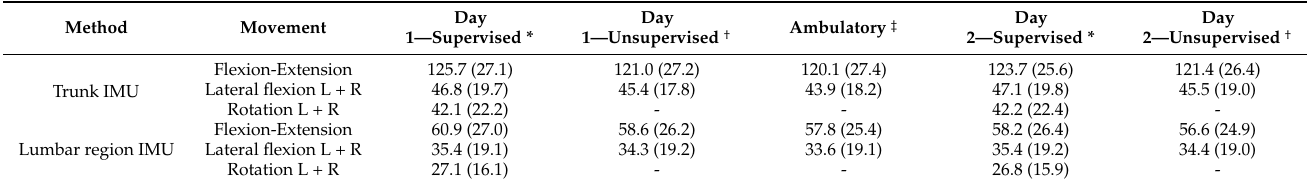
Table 3. Range of movement of participants measured by IMU sensors.